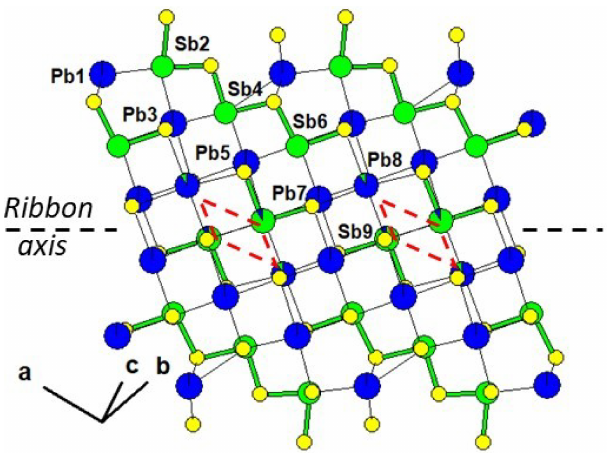
Figure 6. Mixed Pb / Sb sites in the ribbon of the structure of sem- seyite from Herja (sample S1). Red lozenge: neighbouring (Pb,Sb)8 ( × 2) and (Sb,Pb)9 ( × 2) mixed sites. For clarity, mixed sites are un-